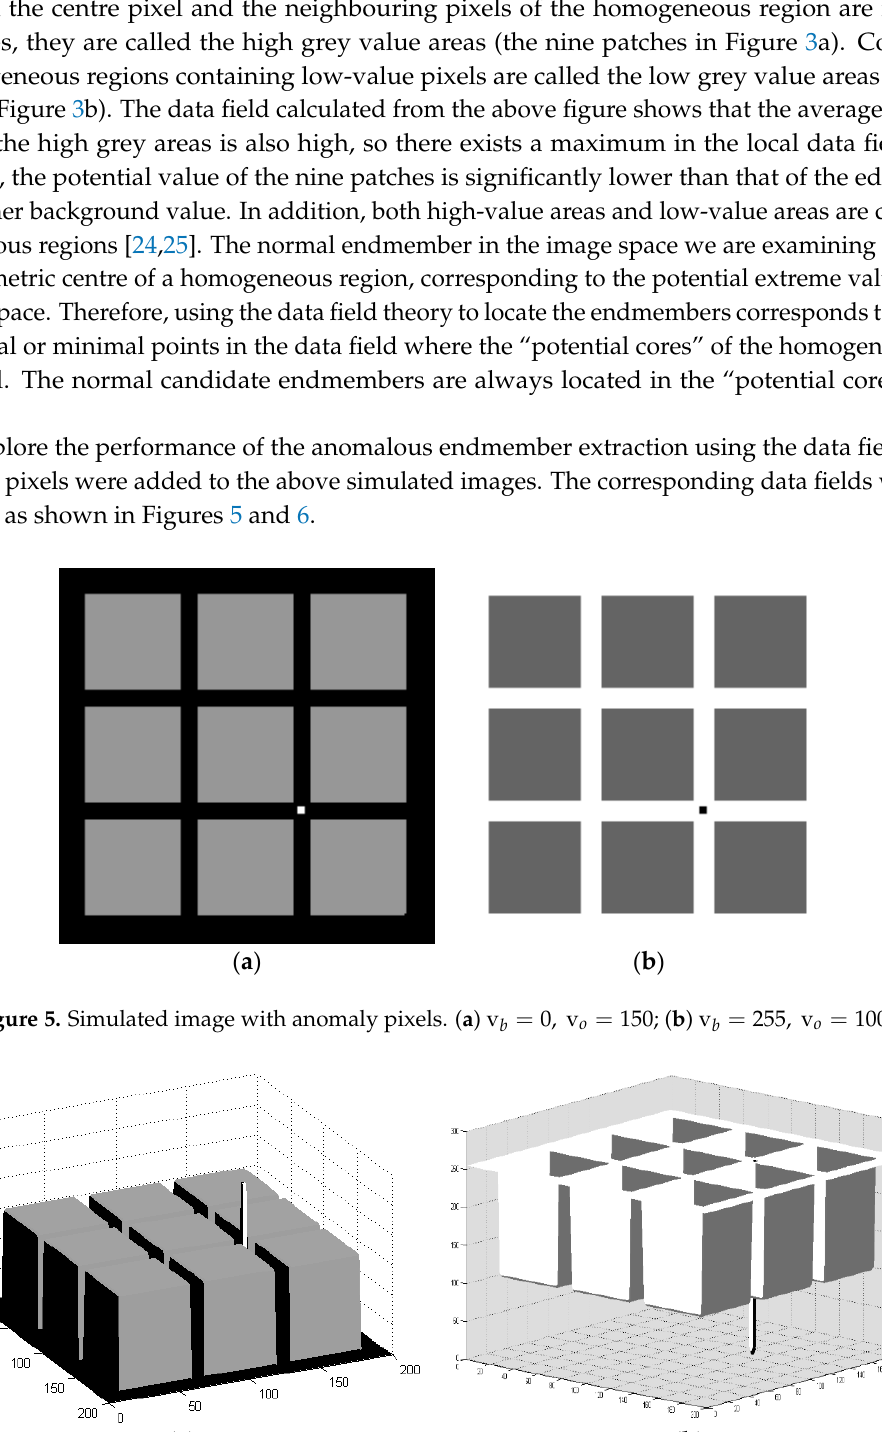
= 0, v o = 150; ( b ) v = 255, v o = b b